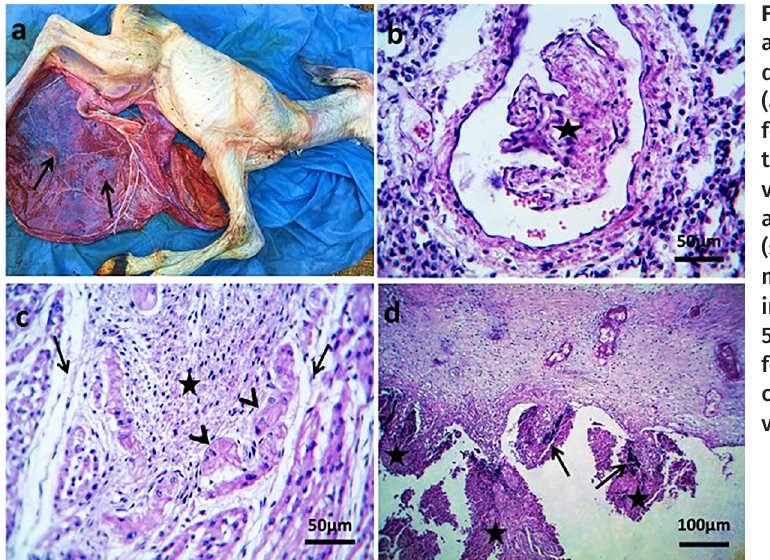
Figure 4. (a) Placenta of full term aborted a she-donkey fetus showing dark red patches on fetal membrane (arrow). (b) Lung of aborted shedonkey fetus showing vasculitis and organized thrombus within pulmonary blood vessel (star) H&E Bar 50µm. (c) Heart of aborted mare fetus showing myolysis (star) or degeneration of some cardiac muscle fibers (arrow heads) and intermuscular edema (arrows) H&E bar 50 µm. (d) Placenta of aborted mare fetus showing necrosis (stars) and calcification (arrows) of the chorionic villi. H&E bar 100